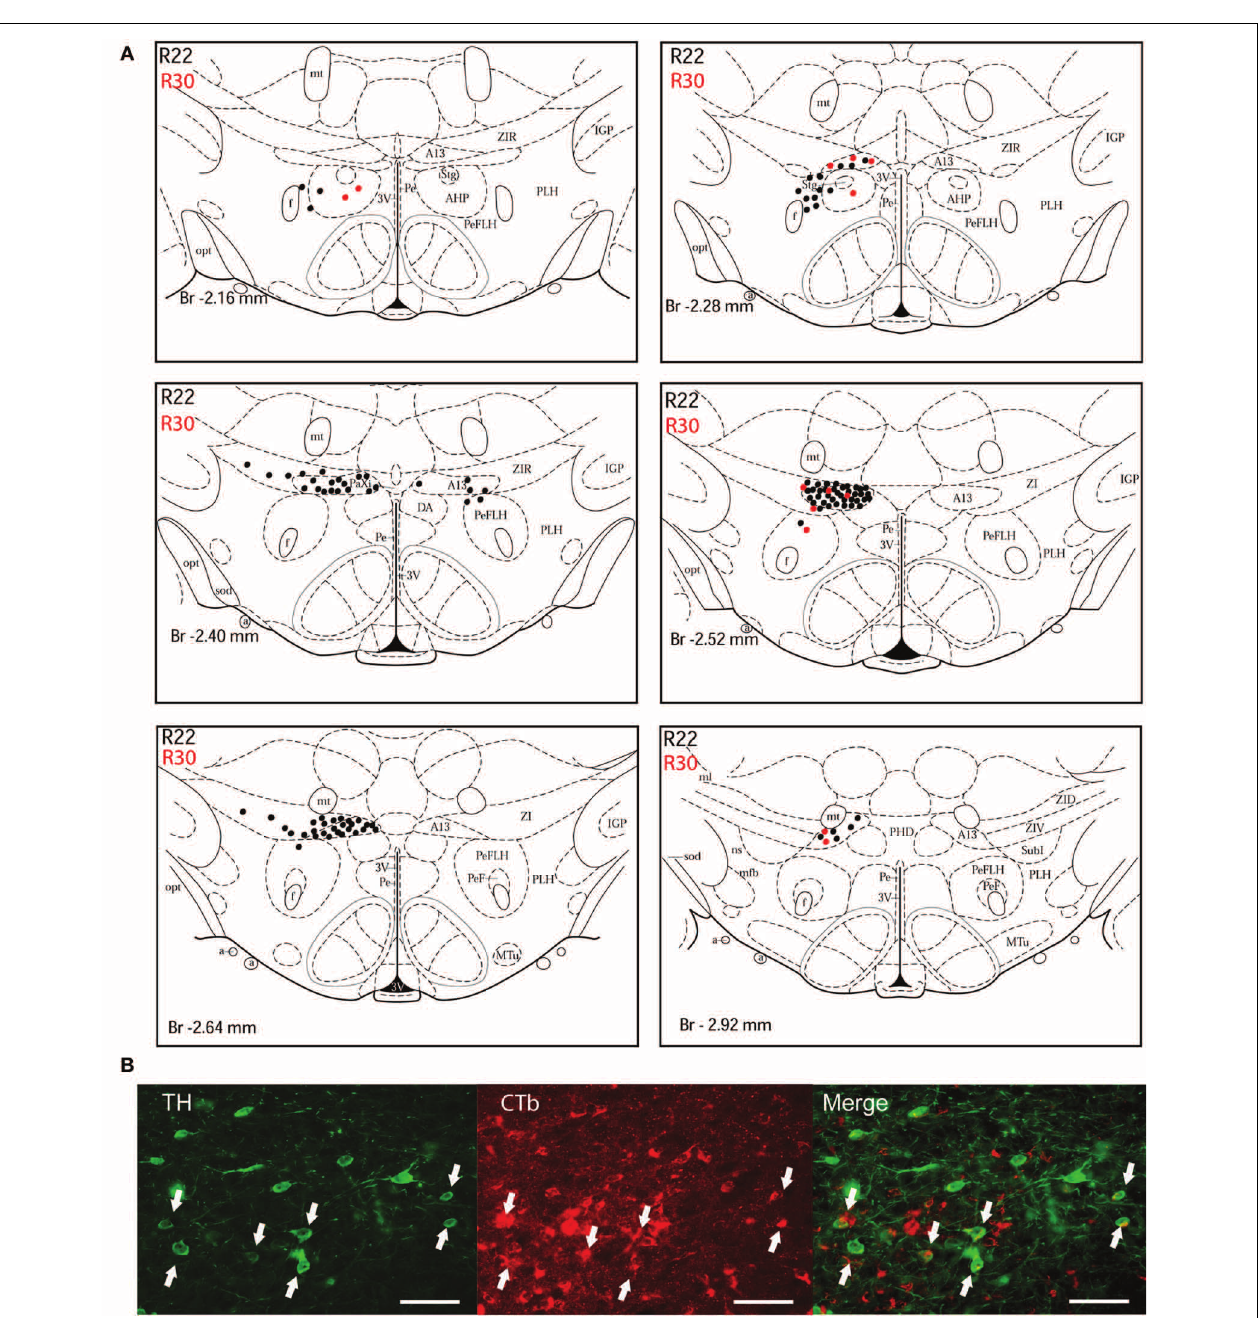
FIGURE 3 | Double-labeled neurons in the A13 dopaminergic cell group projecting to the dlPAG. (A) Diagrammatic representation of the distribution of CTb/TH-positive cells in the A13 cell group, cases R22 (black dots) and R30 (red dots). Figures modified from Paxinos and the second highest number of CTb/TH-positive cells (28% of the total number of double-labeled neurons for R25, and 22% for R30) with no double-labeled neurons found in the extended A10 cell group. The A11 dopaminergic cell group appears at Bregma level − 3 mm where it intermingles with the caudal A13 group. However, dopaminergic cells within the A11 cell group